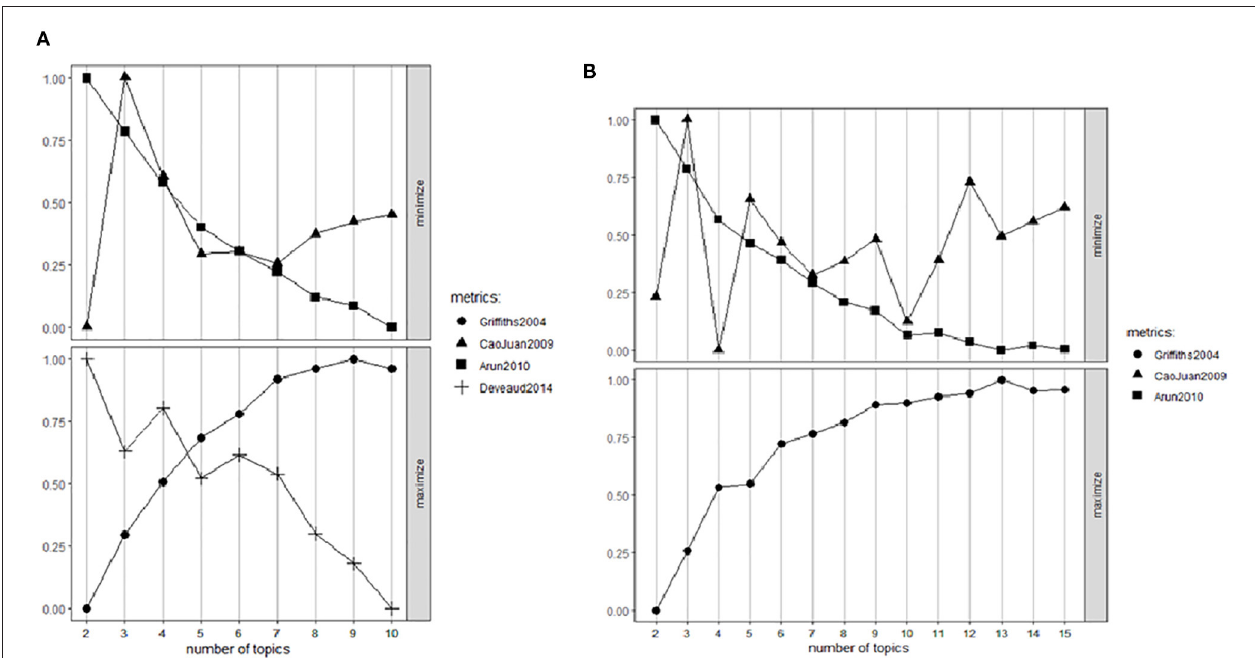
FIGURE 2 | Metrics analysis to find the most appropriate number of topics for radiographic (A) and treatment planning (B)